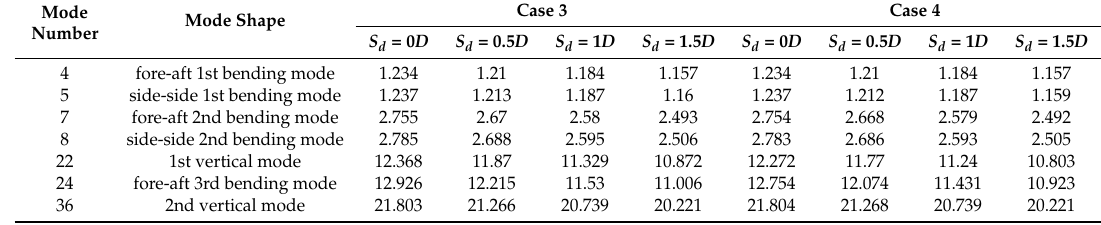
Table 10. Natural frequencies of vibration modes in case 3 and case 4.